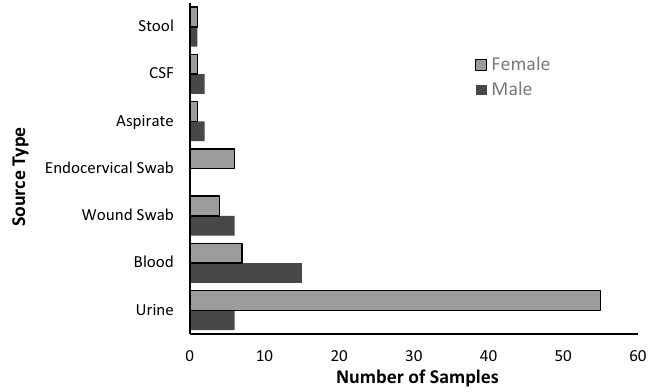
Figure 1. Gender-related occurrence of E. coli infection among hospital